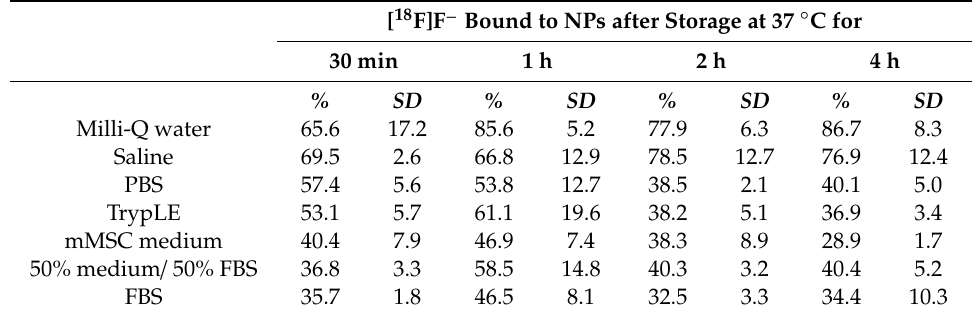
Table 1. Stability of [ 18 F]F − adsorption to Fe 3 O 4 @Al(OH) 3 NPs after continued exposure to di ff erent media. [ 18 F]F − Bound to NPs after Storage at 37 ◦ C